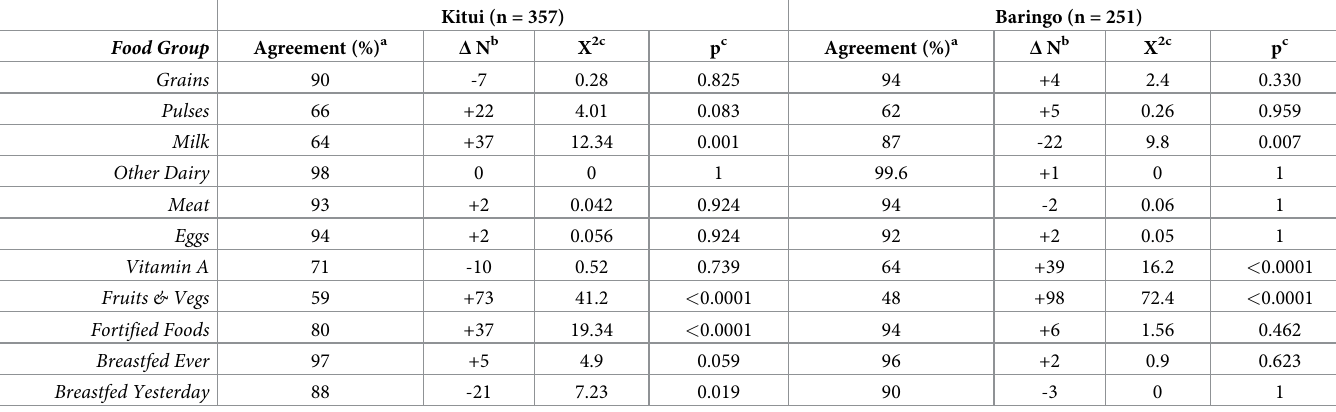
Table 5. Comparison of MDD food group reporting via CATI in Kitui and Baringo counties.